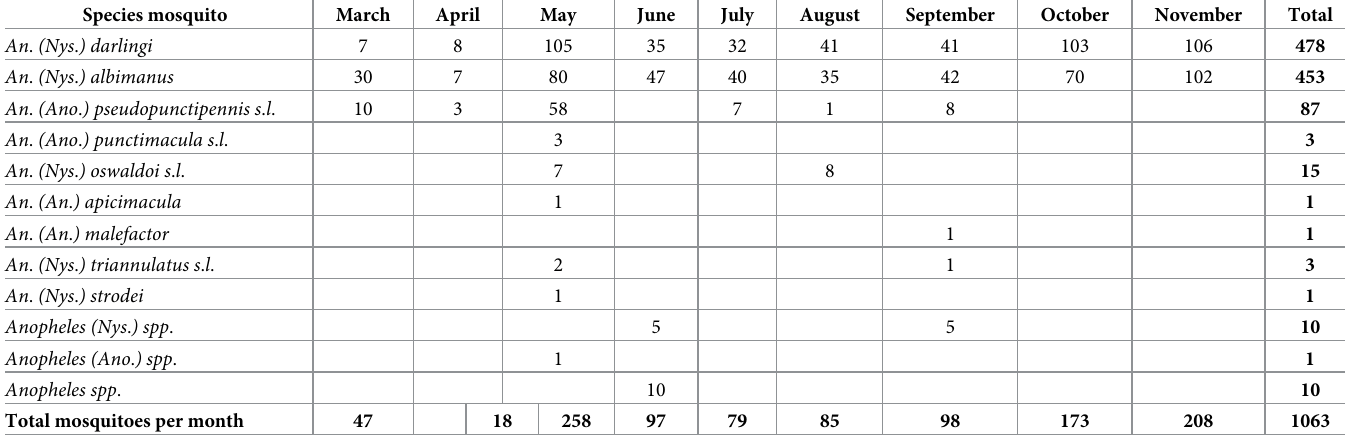
Table 4. Number of Anopheles mosquito species captured with protective human-baited capture and CDC light traps per month in the communities under study in the Darien Region, Panama, 2016. Species